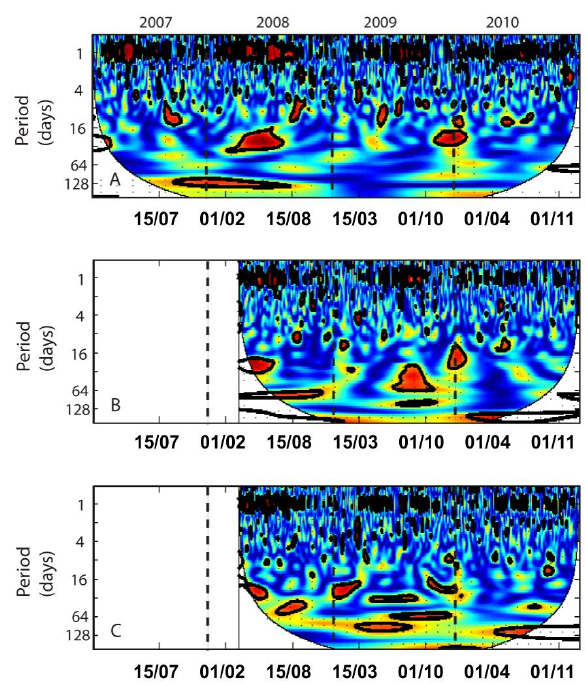
Fig. 8. Wavelet coherence analysis (WCA) output showing tem- poral correlation over four years (2007–2010) between GPP and the temperature independent soil CO 2 efflux, R s (A) and its com- ponents, R r (B) and R m (C) at the Straits Enclosure, Alice Holt forest. The shades for power values are from blue (low values) to red (high values), thick black contour lines represent the 5% signif- icance level; the thin black lines indicate the cone of influence that delimits the region not influenced by edge effects. Dashed lines separate the four years. See previous figures for